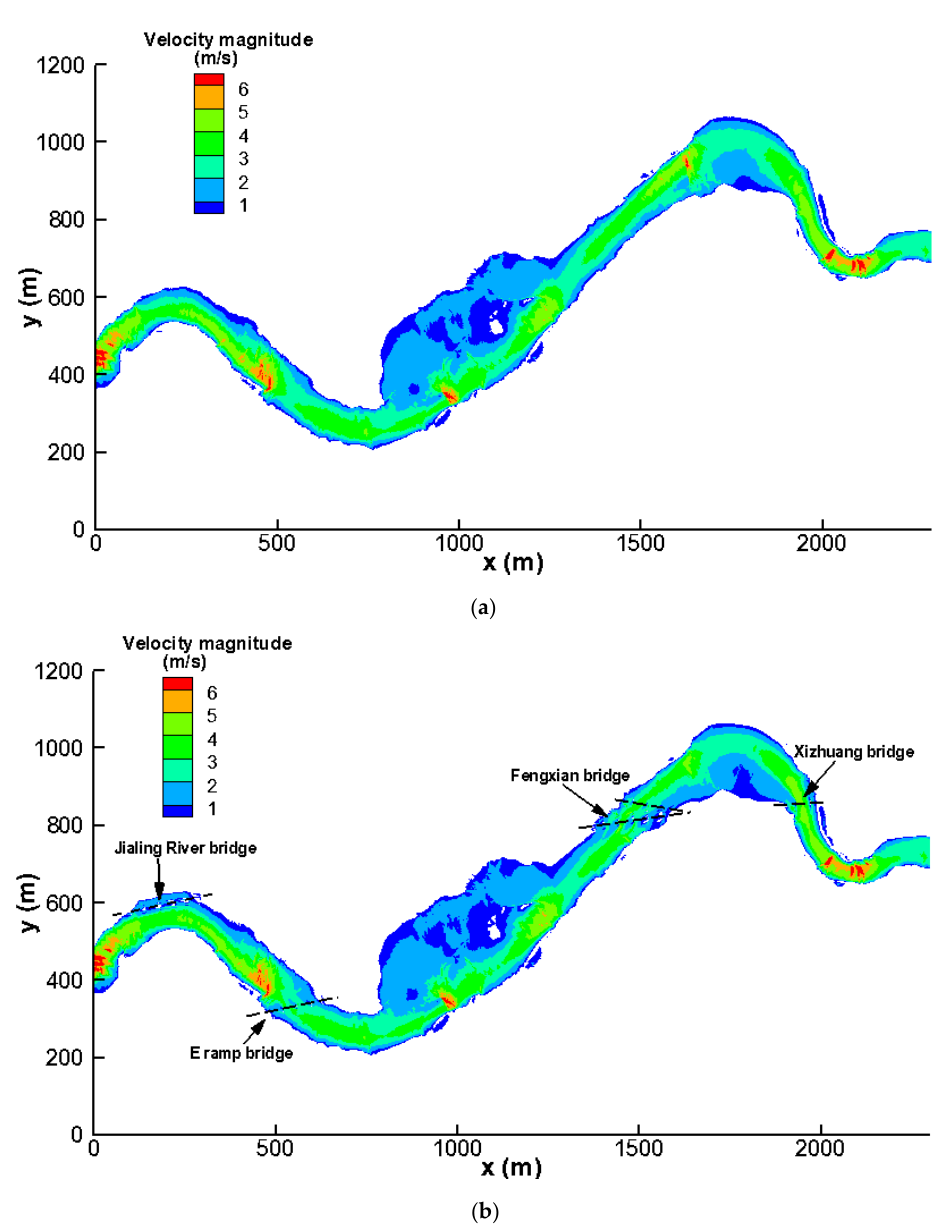
Figure 9. Distributions of the computed velocity magnitude for 10-year flood conditions. ( a ) Results without bridge piers, and ( b ) results with bridge piers.